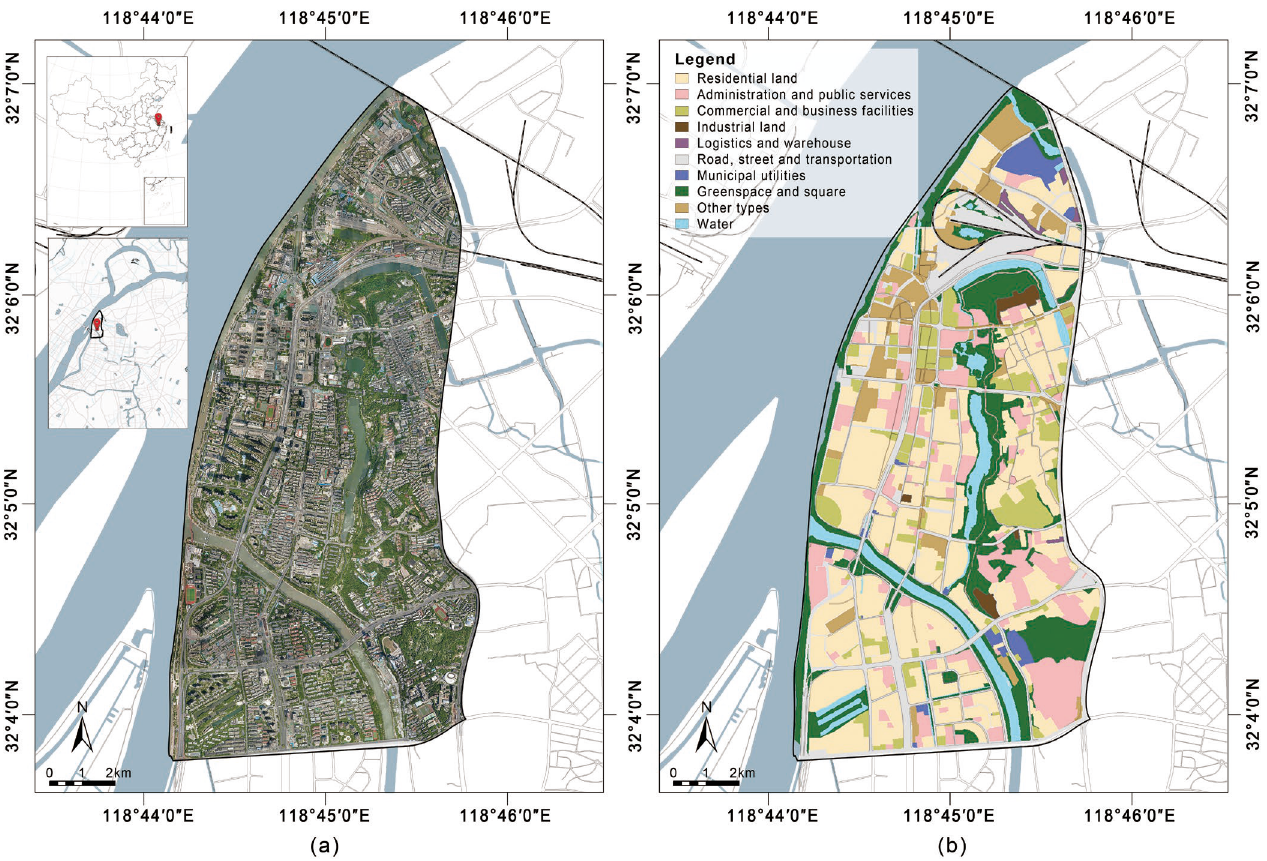
Figure 1. The location of the study area: ( a ) the visible light image taken by DJI Mavic 2; ( b ) the land use types of the study area.